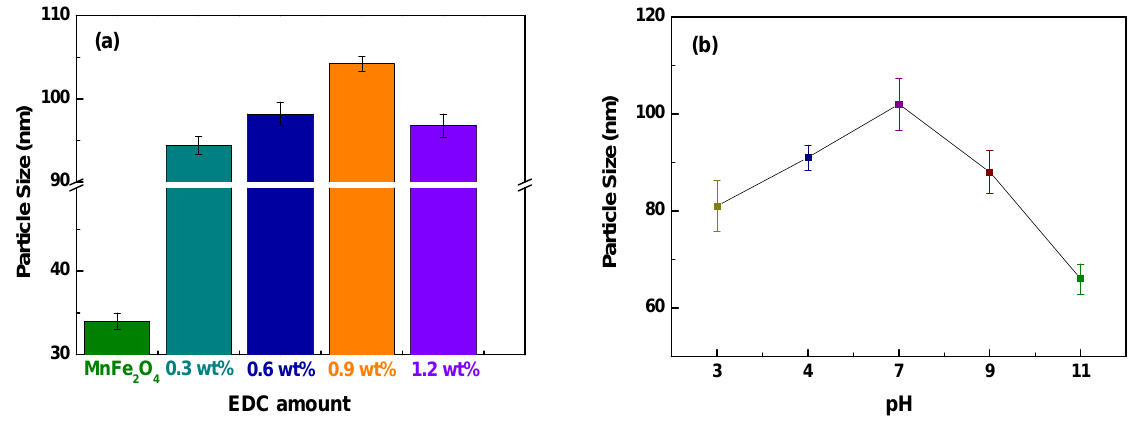
Figure 5. Average hydrodynamic size of chitosan-MnFe O MNPs dependent on (a) the 2 4 EDC concentration used during chitosan coating in DI water and (b) pH-dependent average O MNPs at 0.9 wt % EDC. Error bars represent the hydrodynamic size of chitosan-MnFe 2 4 standard deviation for three replicates. pH buffers (Metrepak pHydrion buffers, Brooklyn, NY) used include: pH 3 and 4: 0.05 M potassium biphthalate pH 7: 0.05 M phosphate; pH 9: 0.04 M sodium bicarbonate/sodium carbonate and pH 11: 0.03 M sodium bicarbonate/sodium